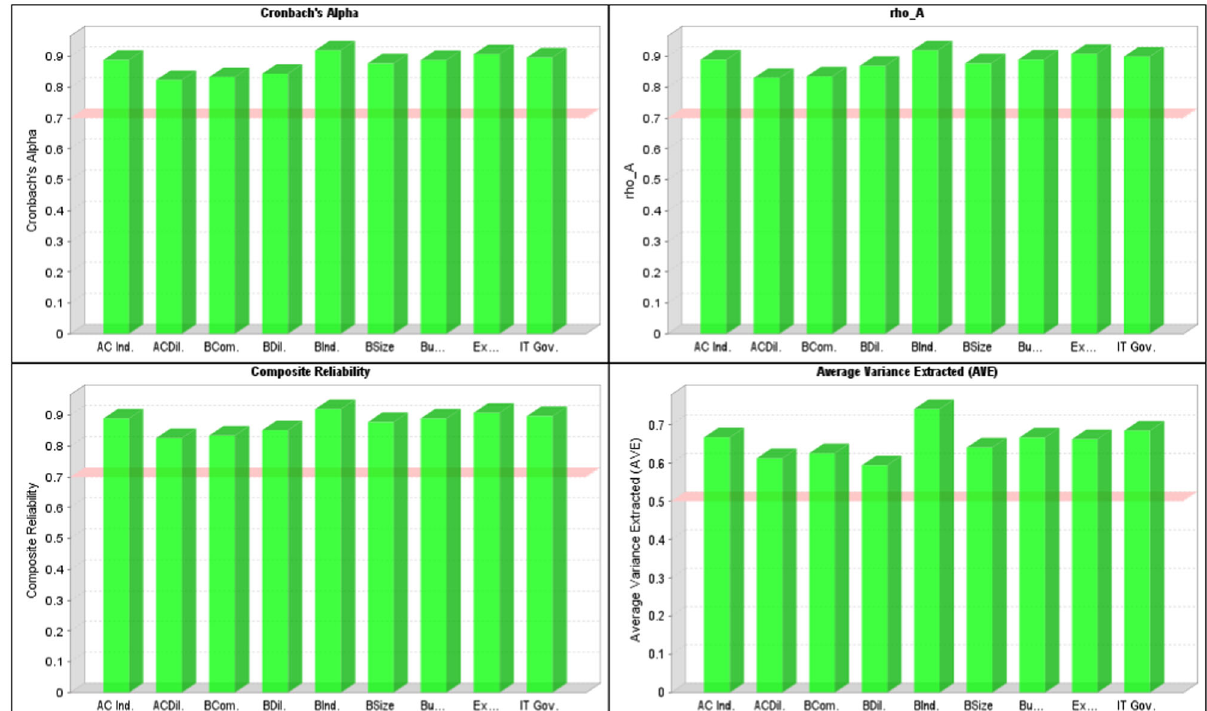
Fig. 2 Reliability and validity. This fi gure shows the values of CA, Roh_A, AVE, and CR. All values are higher than the criterion values, exceeding the lowest value line.